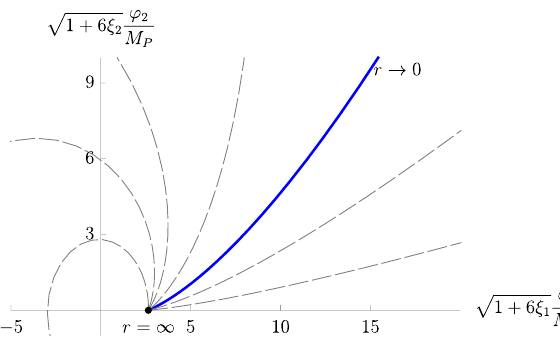
Figure 2 . The classical con(cid:12)gurations of the model (4.21)|(4.24), satisfying the vacuum boundary conditions, eq. (4.31), at in(cid:12)nity. The solid blue line represents the singular instanton obeying eqs. (4.32), (4.37). It is the only con(cid:12)guration with the (cid:12)nite asymptotics of (cid:18) . The dashed lines show examples of other con(cid:12)gurations. All solutions are distinguished by their fall-o(cid:11) at in(cid:12)nity, (cid:18) (cid:24) cr (cid:0) 2 , r ! 1 . The parameter c is used as a shooting parameter in numerical calculations. The parameters of the model are (cid:24) 1 = 1, (cid:24) 2 = 1 : 1 and (cid:14) = (cid:21) =